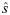
Credible intervals quantify uncertainty in overlap estimates.By using Eq (8), 90% credible intervals are show above as error bars around the point estimates s^ for varying true overlap s. As sampling rate increases from na = nb = 30 (left) to 40 (middle) and to 50 (right), credible intervals shrink, indicating a reduction in uncertainty. In expectation, 90% of intervals cover the true overlap (dotted line).